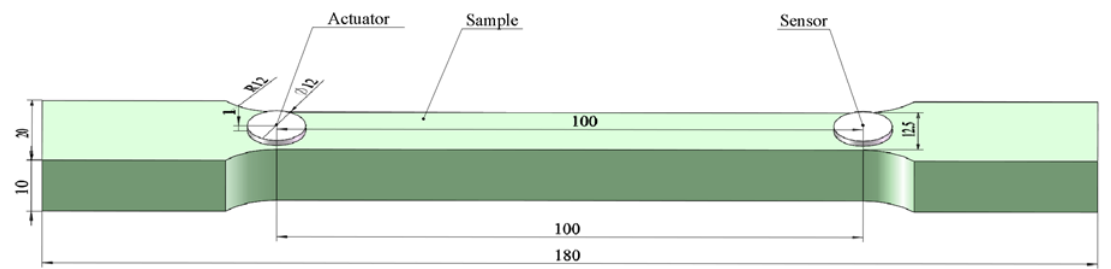
Figure 2. Tensile samples with two PZTs: ( a ) Before the test; ( b ) After the destructive tests.